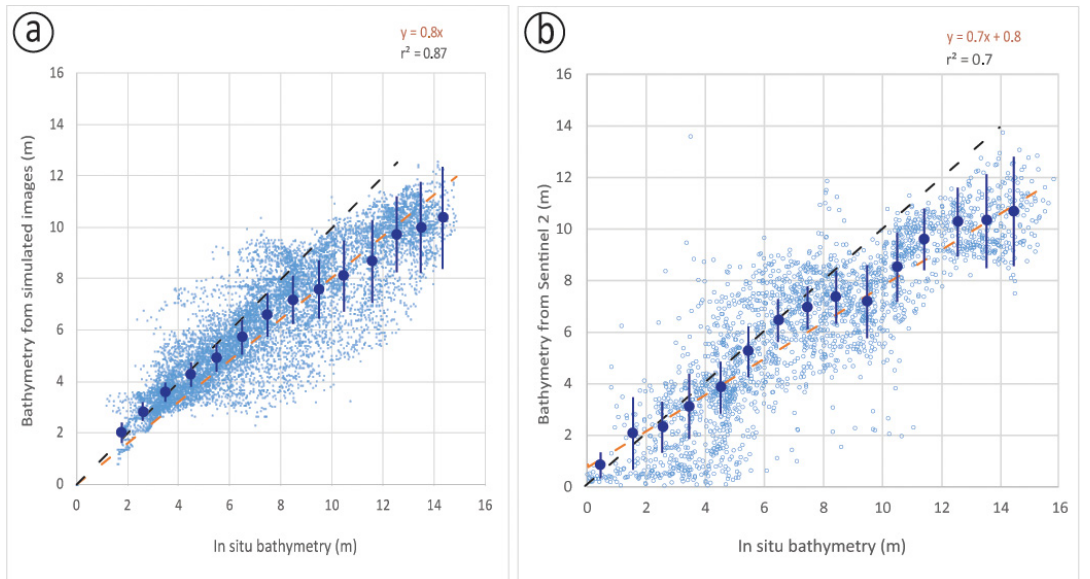
Figure 6. (a) Scatterplot of the in situ bathymetry versus the bathymetry from the simulated waves. ( b ) Scatterplot of the in situ bathymetry versus the bathymetry from Sentinel 2.The dark blue dots represent the mean value per bin, and the blue bars represent the RMSE per bin; please see the main text for further explanations. The dark dotted line represents the 1:1 correlation line. The orange dotted line represents the linear fit to the data, the best-fitting equation of which is located at top of the graph, along with the corresponding r 2 value.